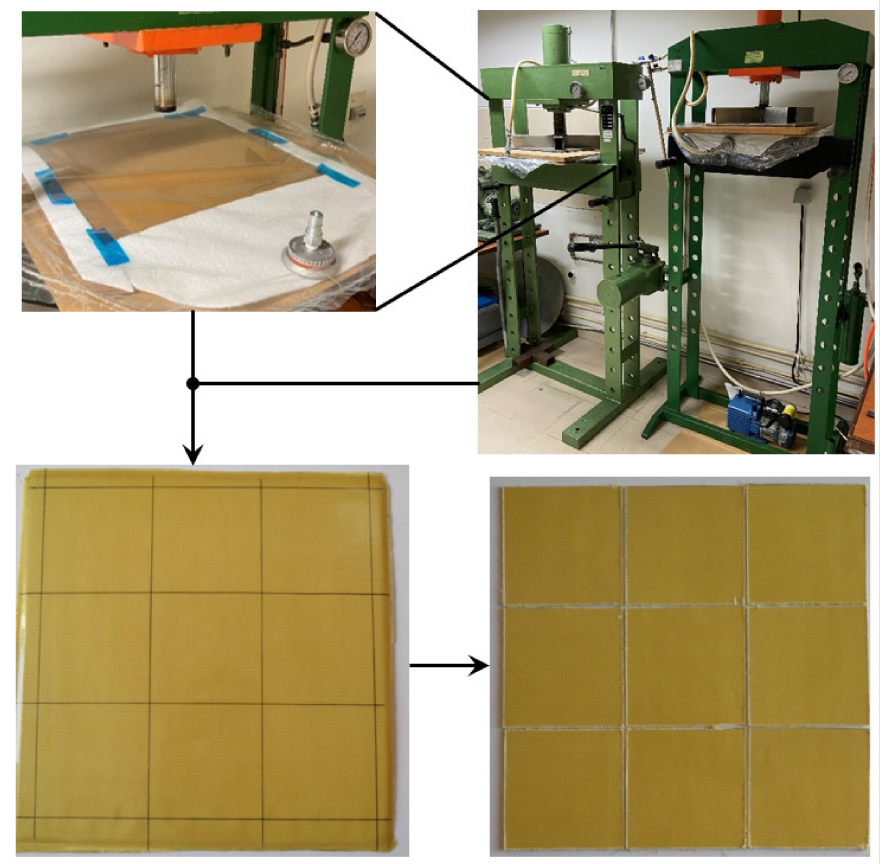
Figure 1. Details of the manufacturing process.